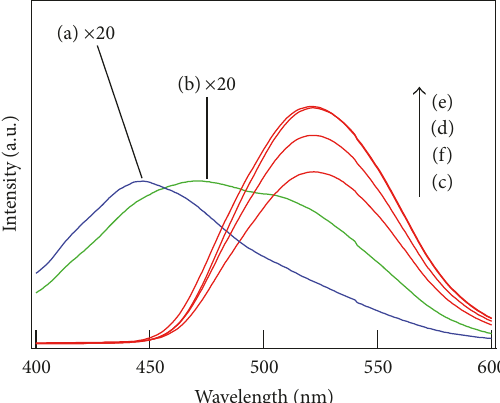
Figure 6: PL spectra of as-prepared APA sample (a) and the samples treated in HQ solutions at 100 ∘ C for 10min with different concentrations: 1mM (b); 3mM (c); 5 mM (d); 7 mM (e); and 10mM (f). The excitation wavelength was 370